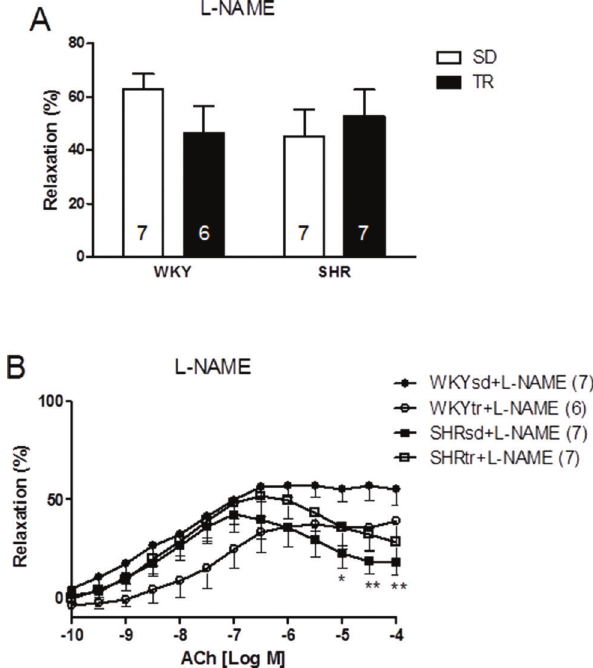
Figure 3 - Relative maximal endothelium-dependent vasorelaxa- tion induced by ACh (A) and curves of the maximal endothelium- dependent vasorelaxation (ACh: 10 –10 to 10 –4 M) of the aortas of control WKY (circles) and SHR (square) (B) after a 30-min preincubation with an inhibitor of NO synthesis (L-NAME; 10 -4 M). * p o 0.05 and ** p o 0.01 SHRsd compared with WKY. The data are presented as the mean ±